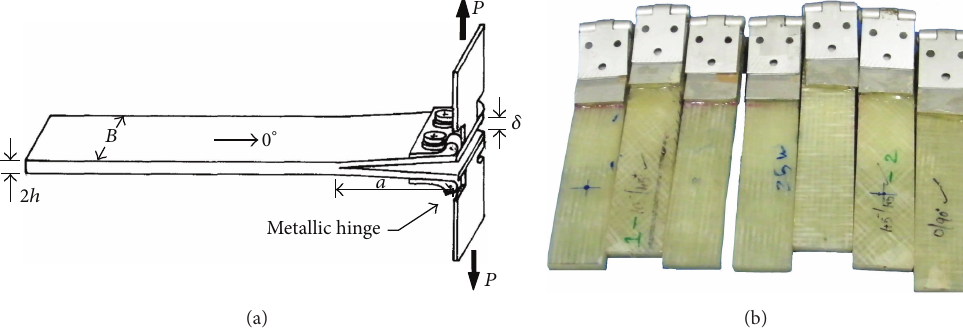
Figure 1: (a) Scheme of unidirectional DCB specimen for mode-I test. (b) DCB specimen of different layups made of